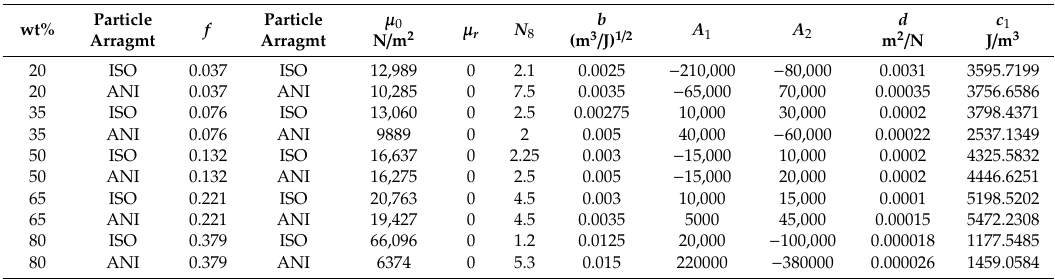
Table 1. Estimated material constant values of µ 0 , µ r , N 8 , b , A 1 , A 2 , d , and c 1 obtained by fitting experimental data with B = 0